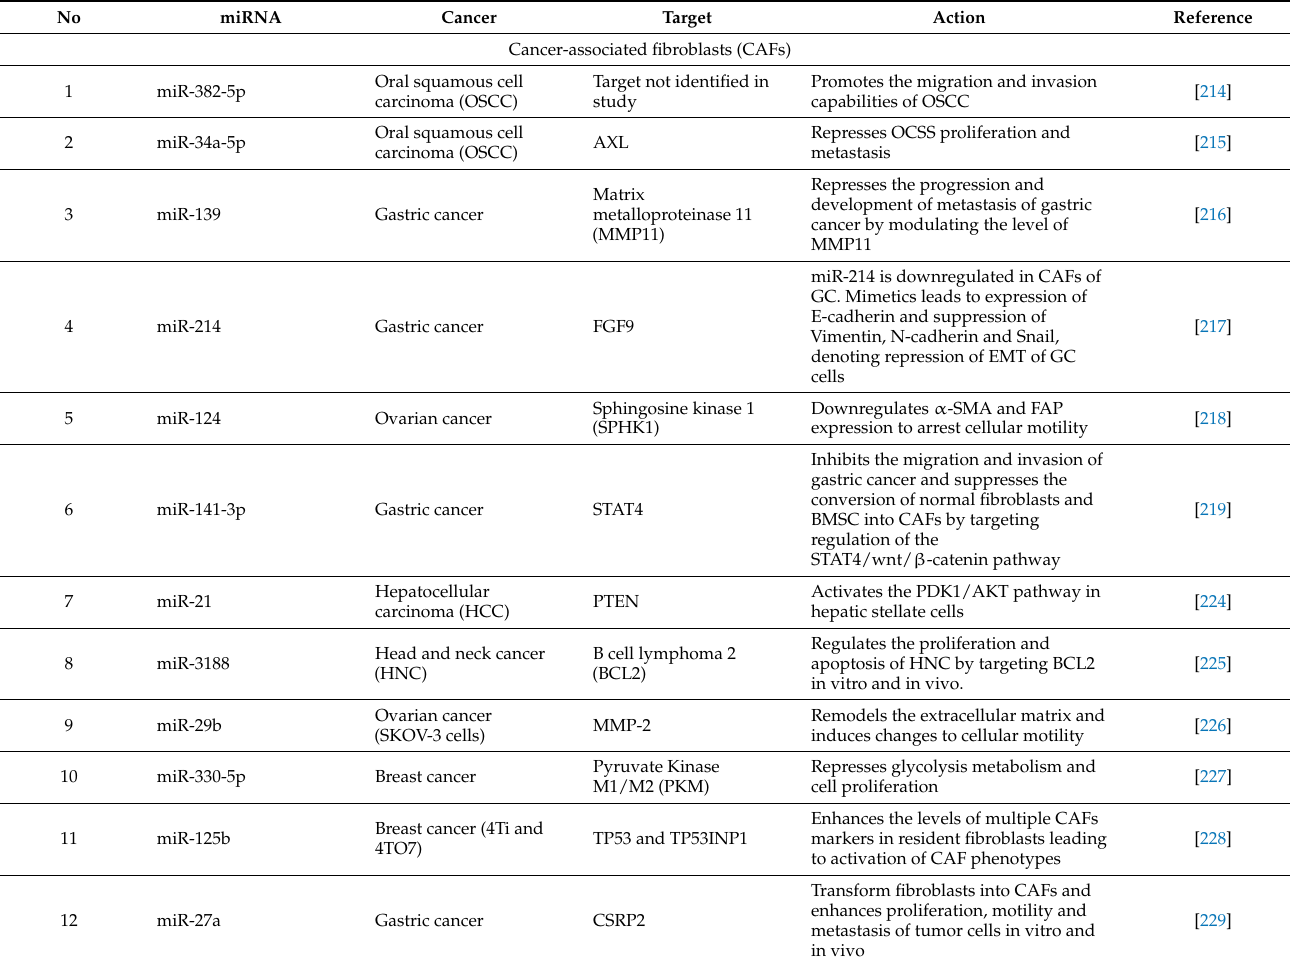
Table 10. The miRNAs implicated in the tumor